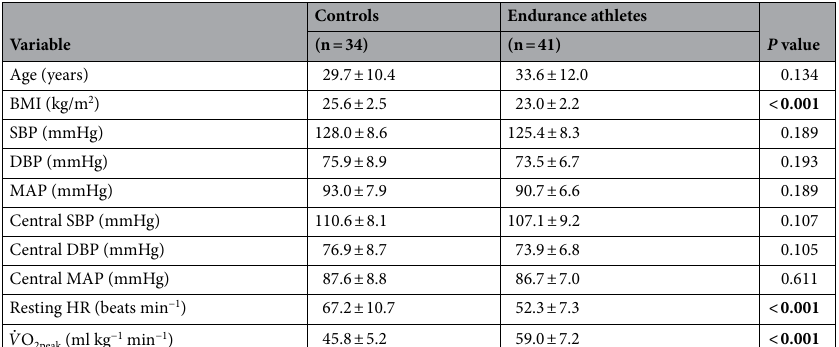
Table 3. Characteristics of endurance athletes and controls in males. Data are expressed as mean ± standard deviation from two-tailed independent samples t -tests or Mann–Whitney U-tests, with P -values below 0.05 bolded. Variances were equal between groups for all variables except for resting HR and body mass index; SBP, systolic blood pressure; DBP, diastolic blood pressure; HR, resting heart rate; maximal aerobic (cardiorespiratory) fitness.